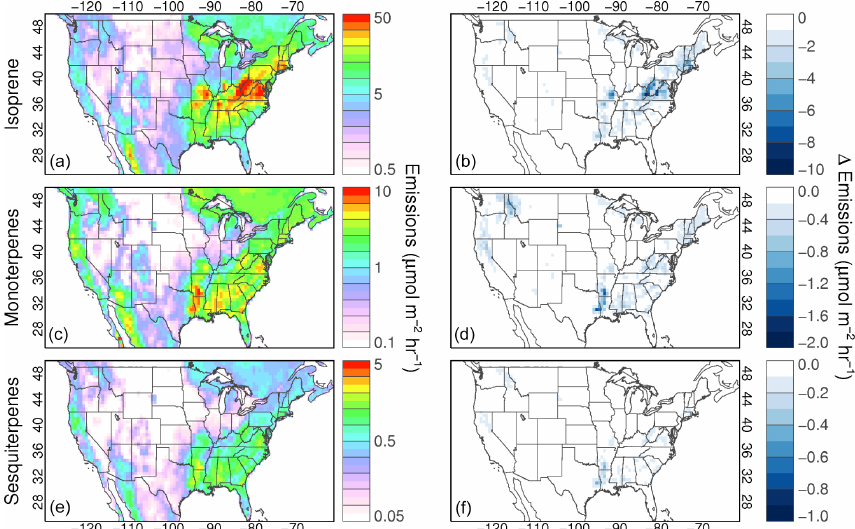
Figure 3. Mean JJA (June-July-August) biogenic VOC emissions in the base scenario (left), and the change in emissions resulting from predicted tree mortality (right). (a, b) Isoprene emissions; (c, d) total monoterpene emissions; (e, f) total sesquiterpene emissions.